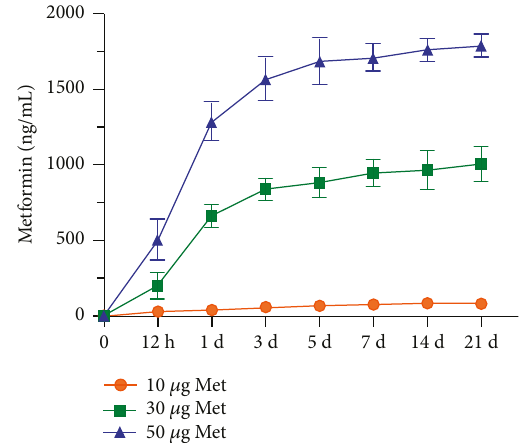
30 휇 g Met 50 휇 g Figure 2: Metformin release from CPC-chitosan sca ff old. CPC + CN + 50Met composite exhibited greater release in the fi rst 12h as compared to CPC +CN +10Met and CPC +CN +30Met. Metformin from CPC-chitosan sca ff olds had sustained release over 21 days. CPC: calcium phosphate